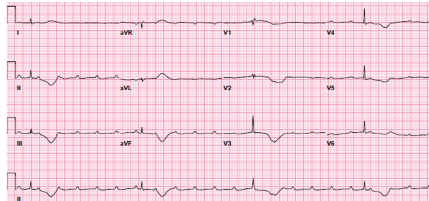
Figure 2: EKG following the procedure showing a complete heart block with an escape